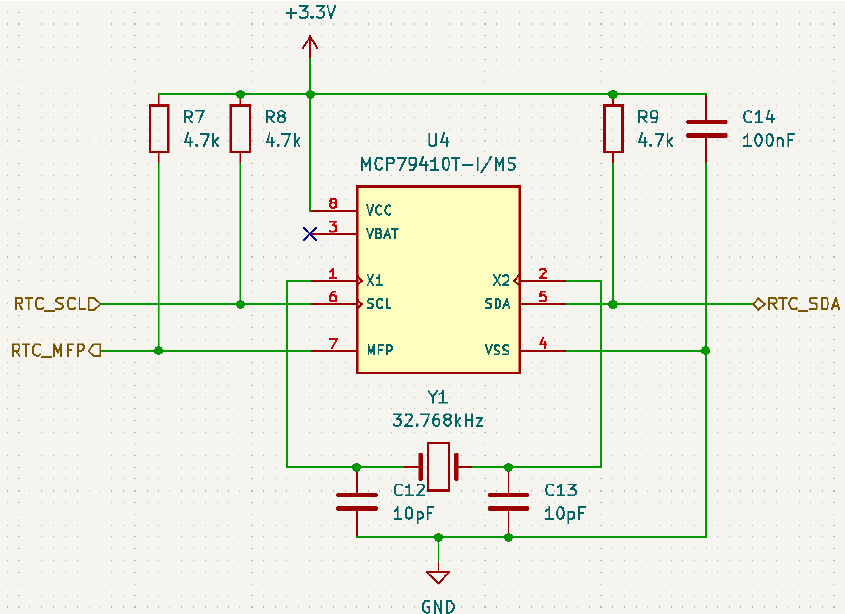
Figure 6. The RTC circuit.